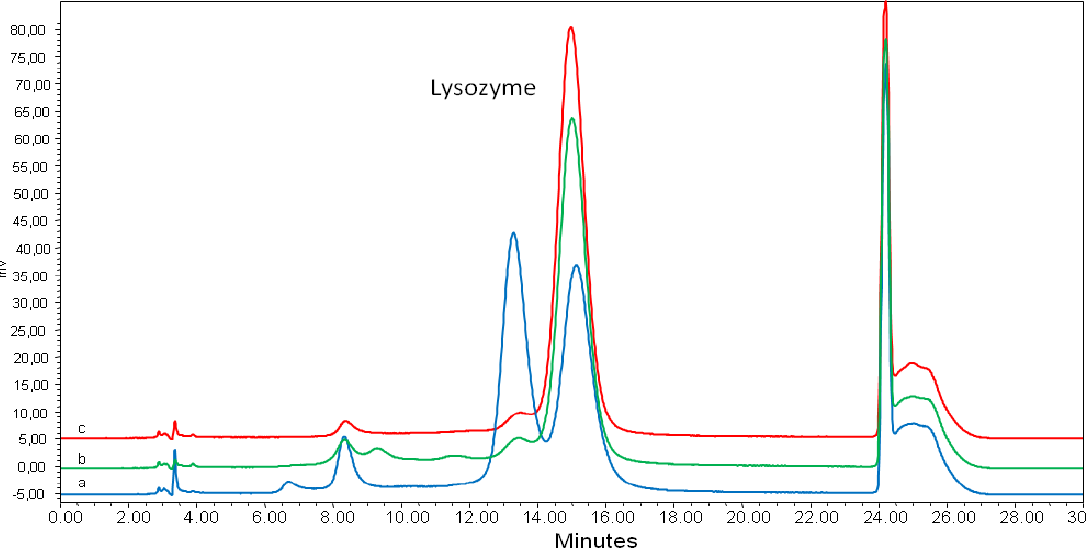
Figure 3. HPLC patterns of lysozyme in commercial preparations nr 13 (pattern a ) and nr 15 (pattern b ) and in lysozyme standard (pattern c